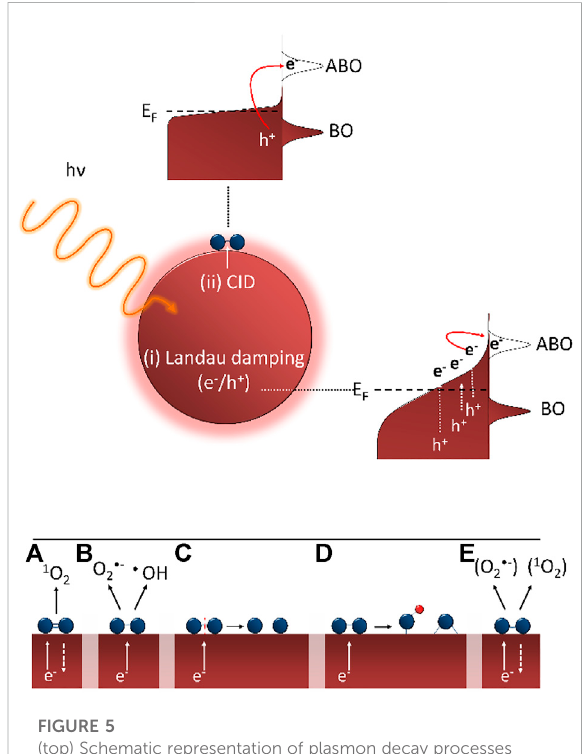
FIGURE 5 (top) Schematic representation of plasmon decay processes leading to indirect (i) or direct (ii) charge transfer of energetic electron to adsorbate (with ABO = antibonding orbital and BO = bonding orbital). Adapted from (Kale et al., 2014; Linic et al., 2015) (bottom) Proposed steps taking place after initial electron transfer: (A) singlet oxygen formation, (B) formation of superoxide and hydroxyl radicals, (C) desorption (reaction) induced by electronic transitions, (D) formation of surface oxides/hydroxides and (E) formation of superoxide-like and singlet oxygen-like